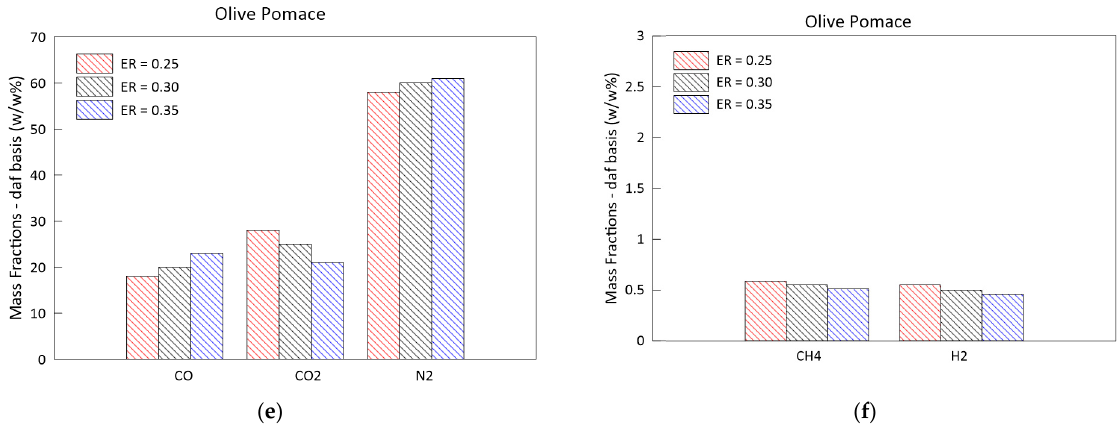
Figure 11. Species mass fractions (on a daf basis) at the reactor exit section, at different ER, for ( a , b ) woodchip case 1, ( c , d ) hydro-char from green waste, ( e , f ) olive pomace gasification.